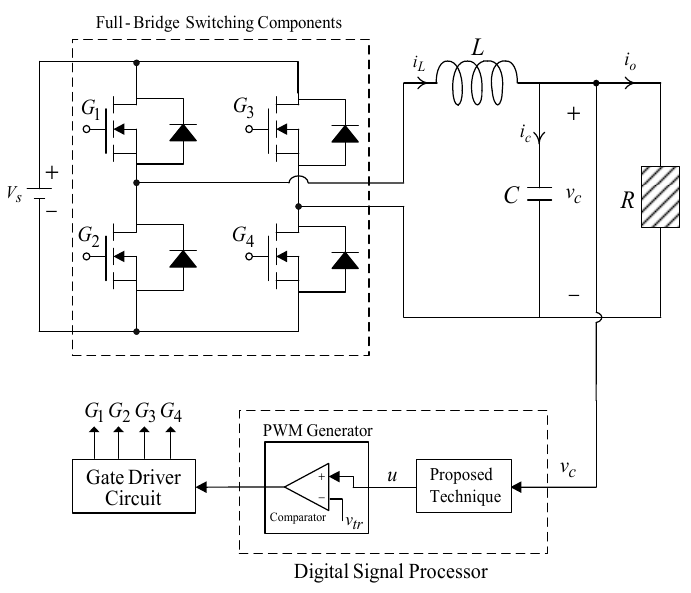
Figure 1. Structure of DC–AC converter.